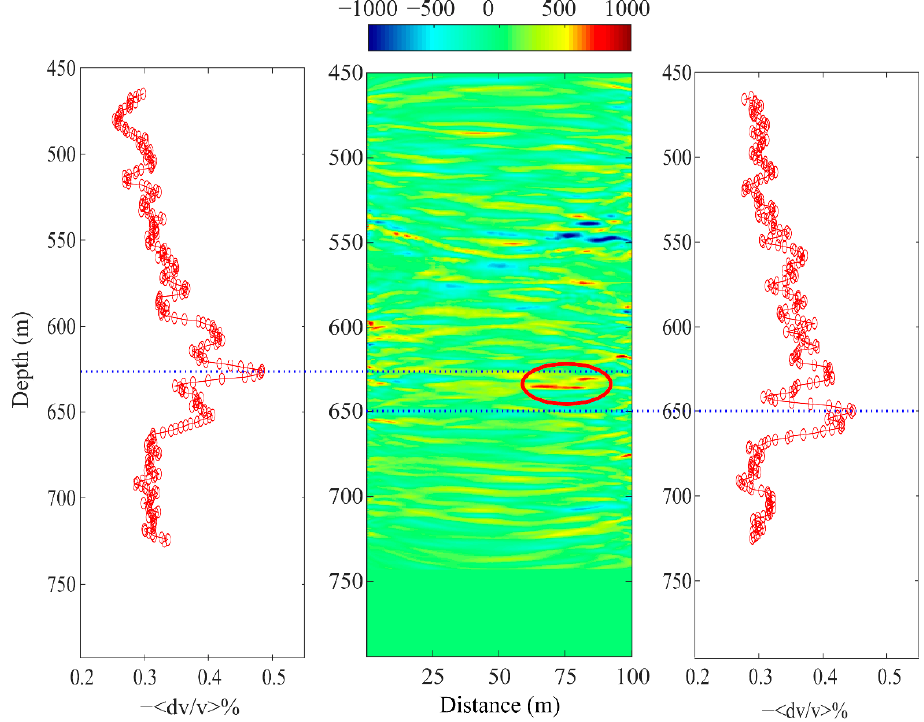
Figure 18. Comparison of the velocity difference between the baseline and second-repeat surveys from waveform tomography ( middle ) and the mean velocity change curves from the upgoing ( left ) and downgoing ( right ) wavefields.